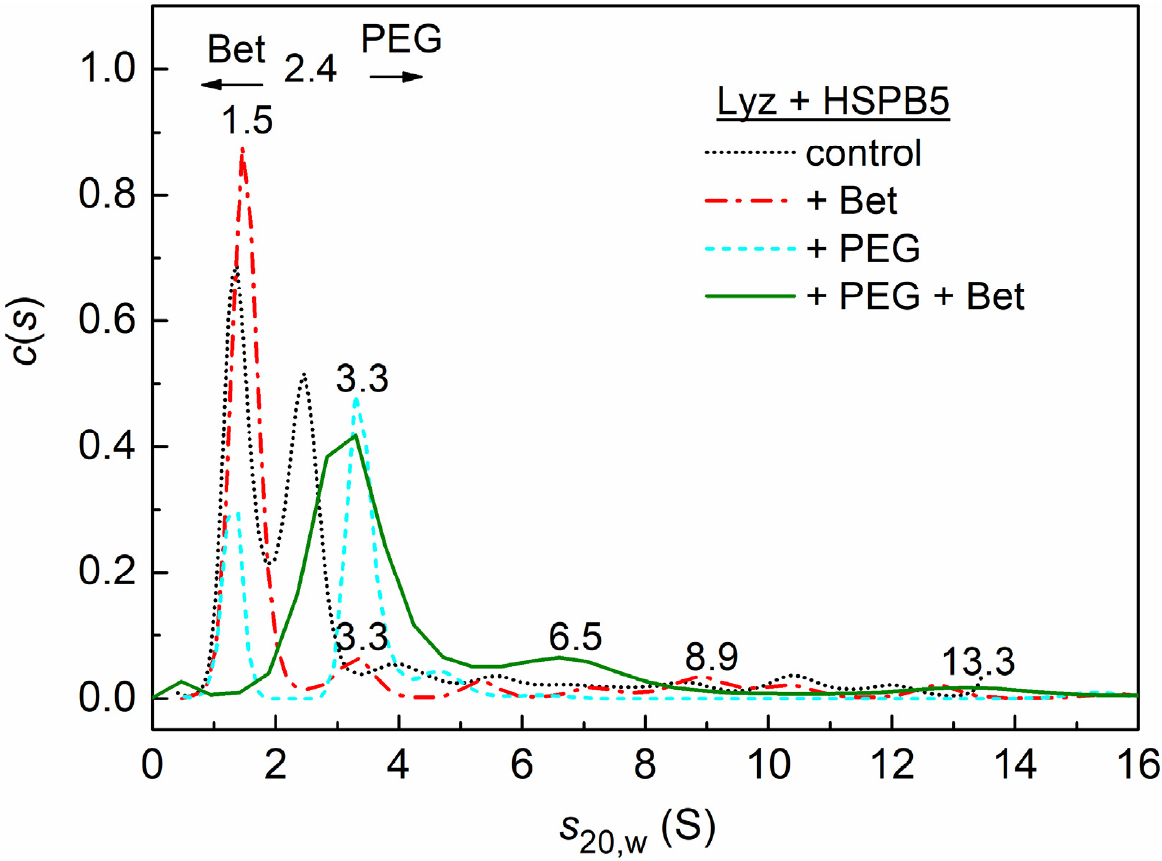
Figure 5. The sedimentation behavior of Lyz (0.15 mg/mL) in the presence of 0.05 mg/mL HSPB5. The differential sedimentation coefficient distributions, c ( s ), for the mixture of Lyz with HSPB5 (black dotted curve) with the addition of 25 mg/mL PEG (red dash-dotted curve), 1 M Bet (blue dashed curve), and 25 mg/mL PEG + 1 M Bet (green solid curve). All c ( s ) distributions were obtained at 37 ◦ C and corrected to standard conditions. The rotor speed was 60,000 rpm for (Lyz + HSPB5) and (Lyz + HSPB5 + PEG) and 48,000 rpm for the other samples.